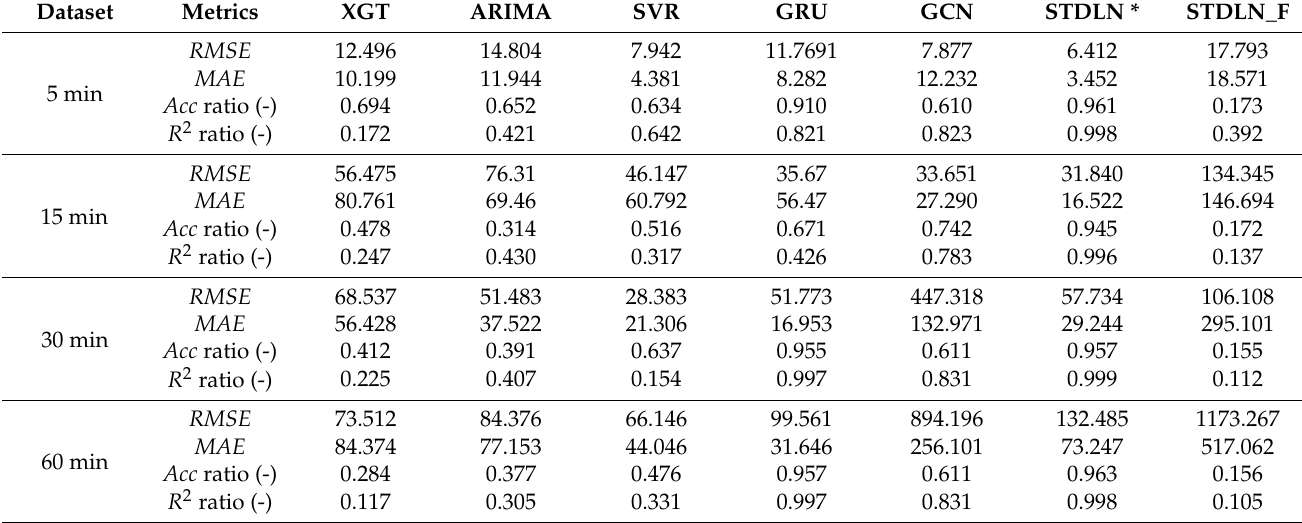
Table 2. The prediction performances of the STDLN model and baseline methods on the